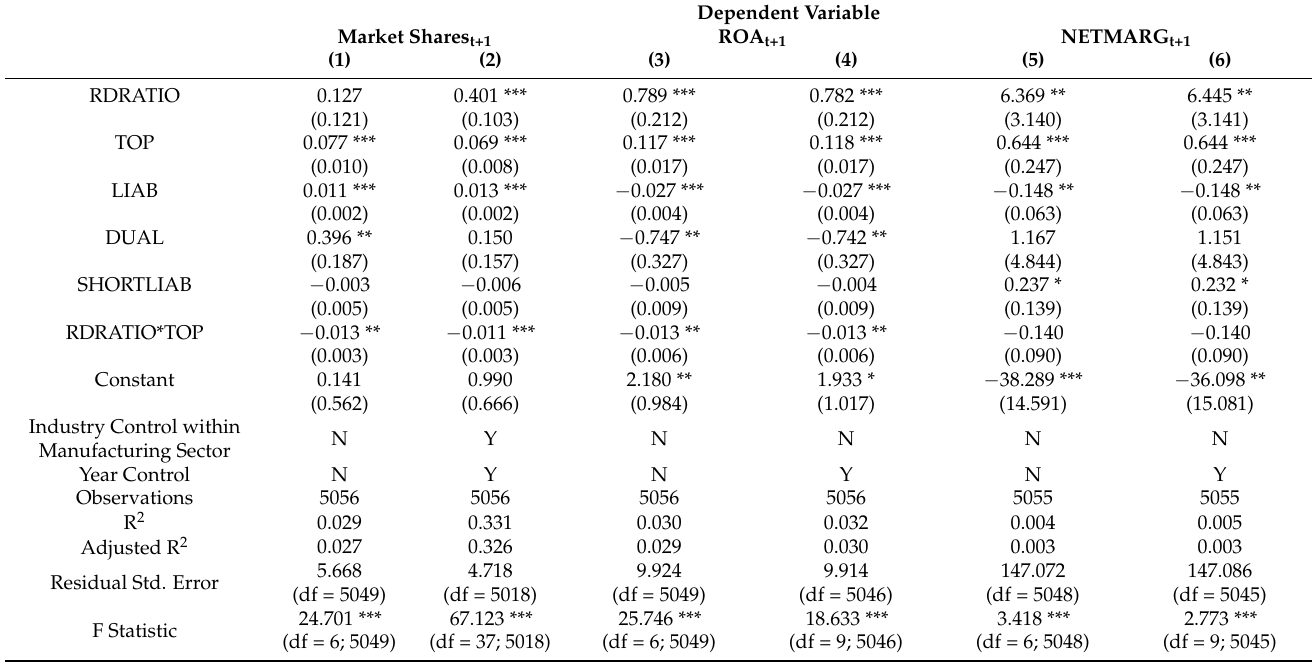
Table 3. Research expense, market power, profitability and earning